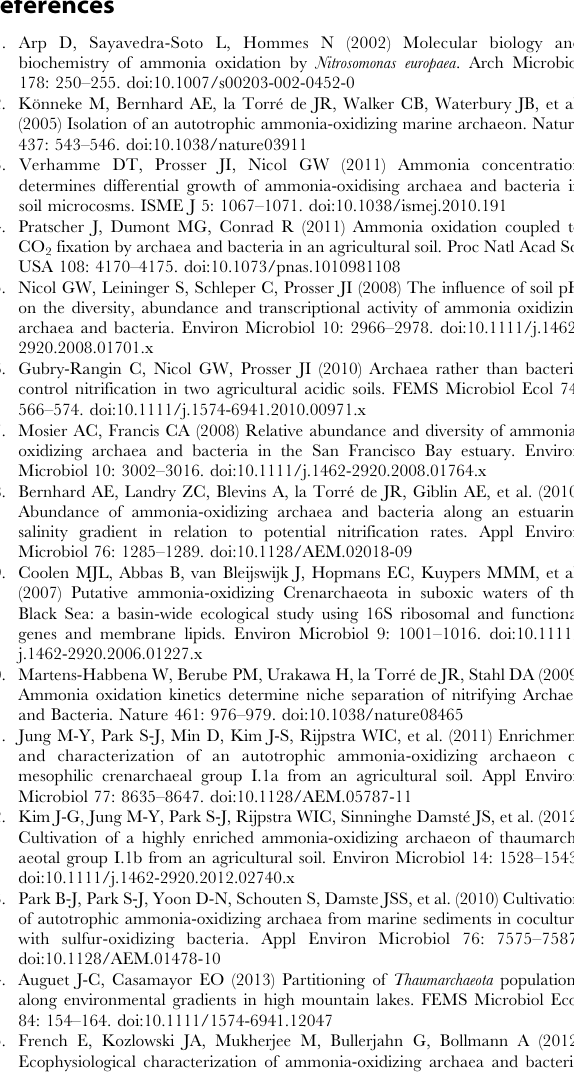
Figure S5 Canonical correspondence analysis (CCA) of AOB amoA sequences in Lake Erie. (TIF) File S1 Combined file containing tables S1 – S13.